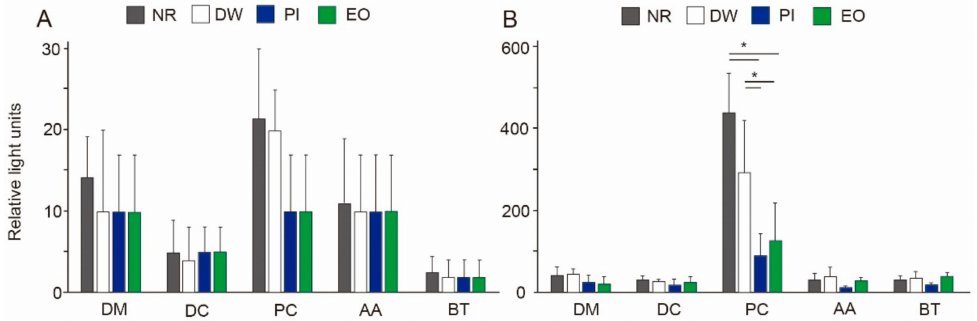
Figure 4. Relative light units (RLUs) at various locations following 10 min of scaling. Results show colony forming units (CFUs) at eHVE distances of ( A ) 10 cm and ( B ) 20 cm relative to the mouth. Results are shown as means ± SD. * p <